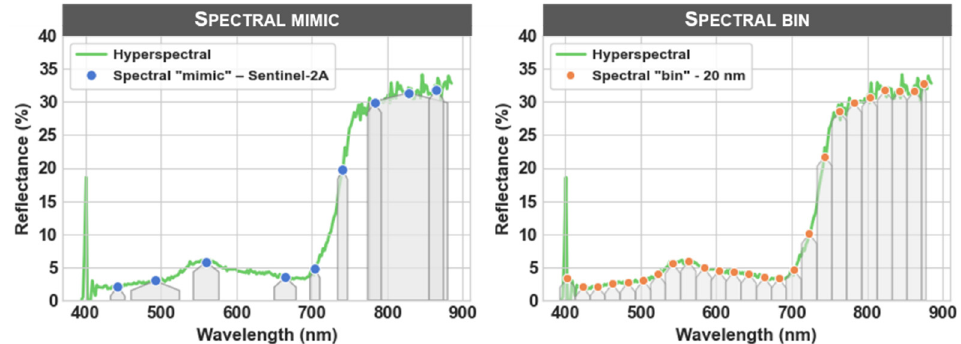
Figure 2. Illustration of the differences among the three binning scenarios from the spectral domain. The green line represents the full hyperspectral spectrum for a single unprocessed pixel ( no spectral binning ), and the points represent the reflectance values and center wavelengths of the spectral “mimic”—Sentinel-2A bands ( left ) and the spectral “bin”—20 nm bands ( right ). The shaded areas represent the bandwidths (full width at half maximum) of the spectrally resampled bands. The pixel data used in this illustration were extracted from an image captured on 2018-06-28 from the Wells experiment.